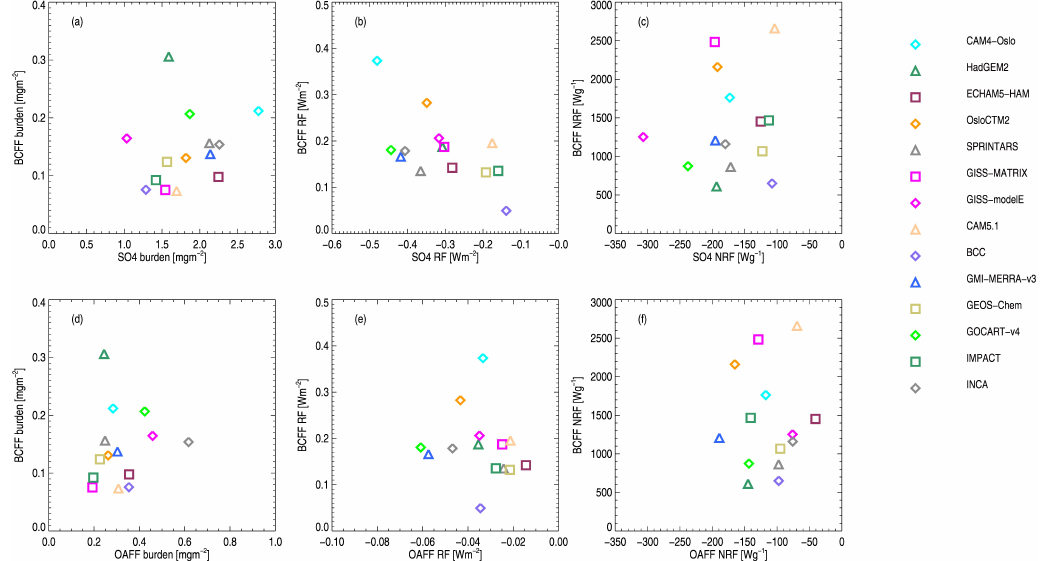
Fig. 15. Correlations between burdens ( a and d ), RF ( b and e ) and normalized forcing ( c and f ), for SO 4 vs BCFF ( a , b , and c ) and OCFF vs BCFF ( d , e , f ).